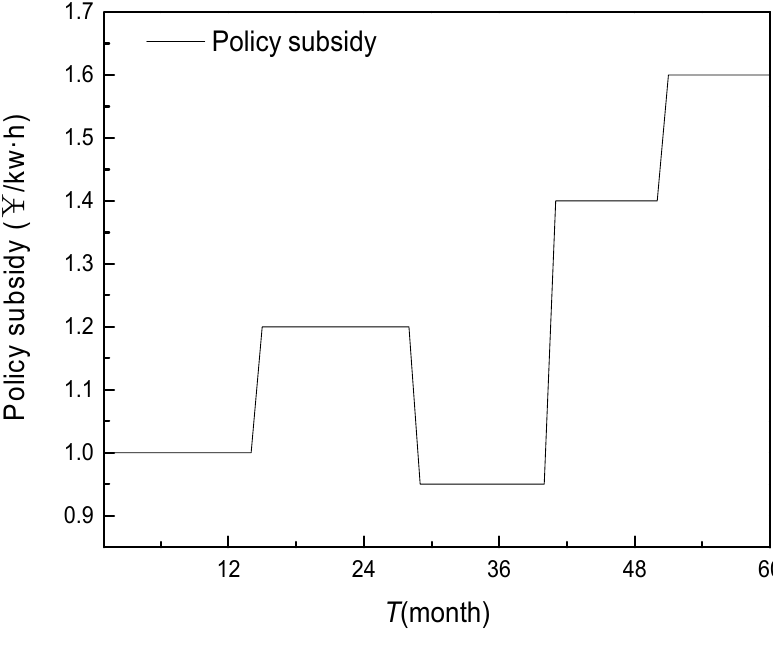
Figure 12. Policy subsidy change.